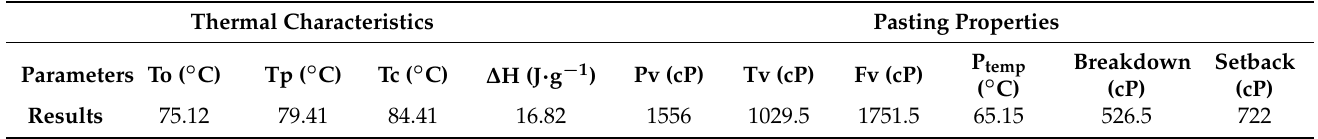
Table 9. Thermal and pasting properties of Ceiba aesculifolia subsp. parvifolia tuber starch. Thermal